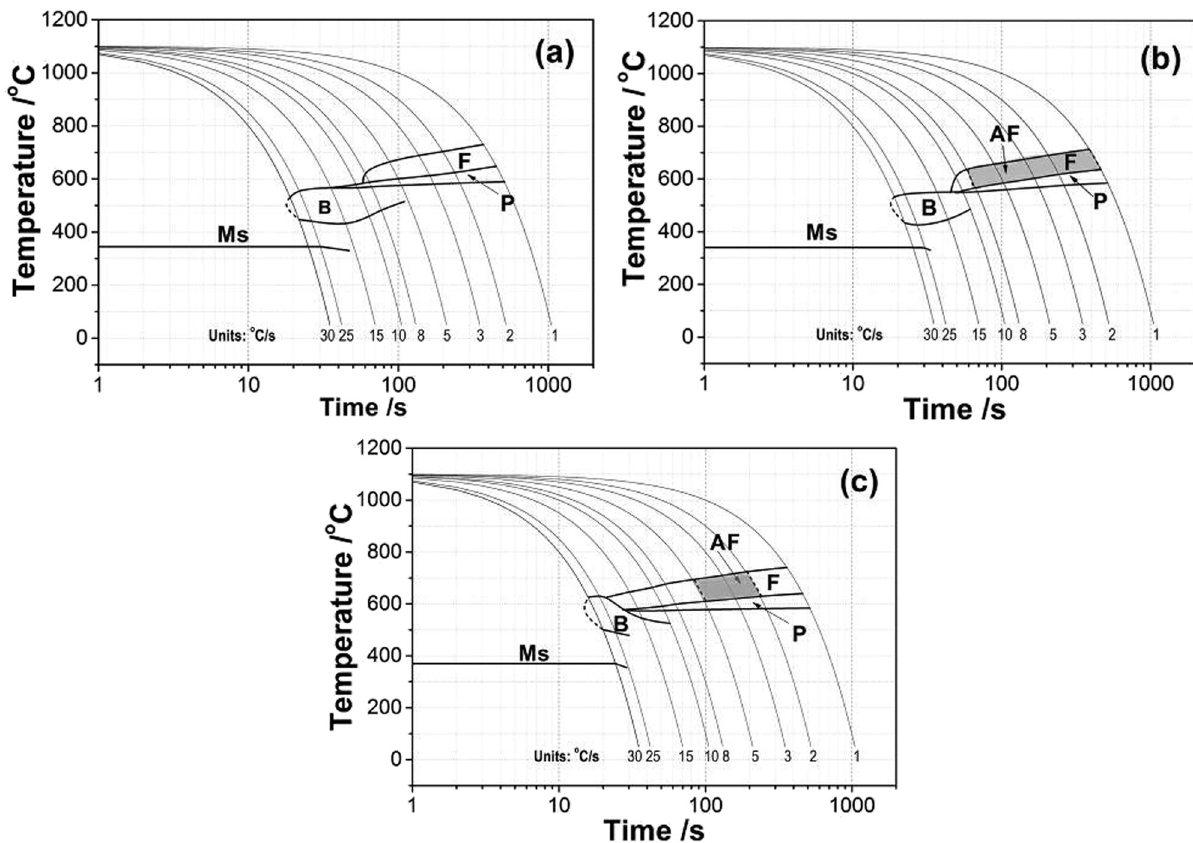
Figure 10: The continuous cooling transformation of the three steels. ( a ) Steel no. 1, ( b ) steel no. 2, and ( c ) steel no. 3.